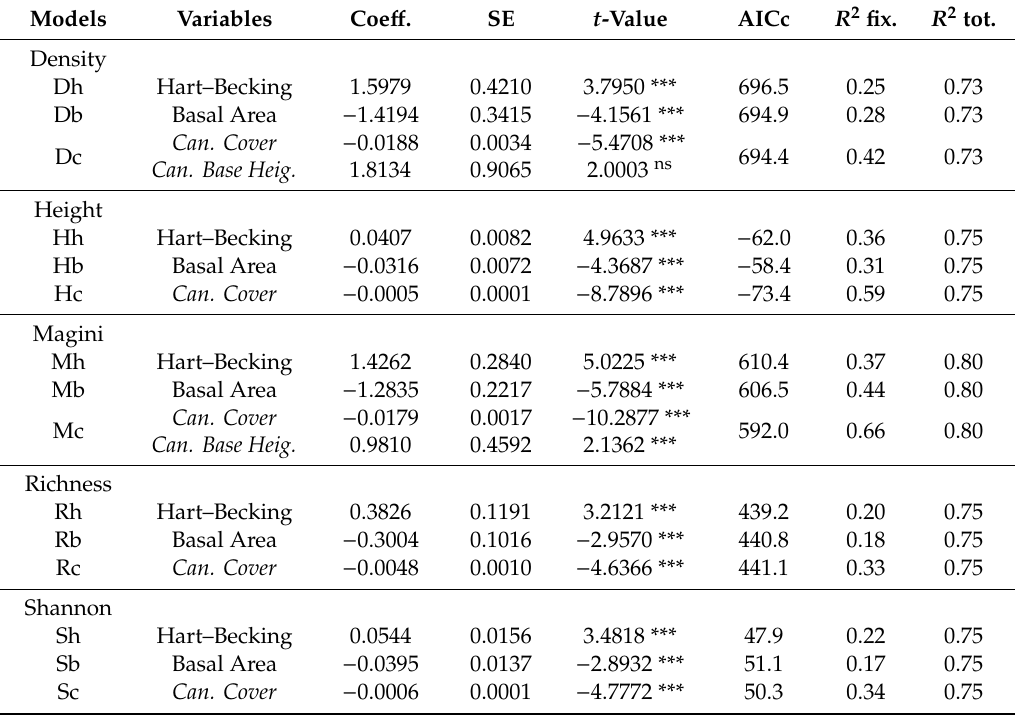
Table 3. Linear mixed models (LMMs) developed to show the relationships between overstory variables (explanatory) and understory variables (independent). Table columns represent the models, the dependent variables, the coe ffi cients of the fixed terms, the respective standard errors, the t -value for each tested coe ffi cient, the AICc of the model, the R 2 of the fixed terms and the total R 2 . Test significance: *** p < 0.001; ns non-significant.